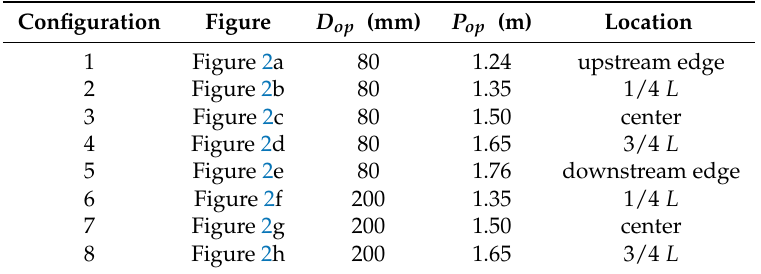
Table 1. Outlet pipe characteristics for the studied